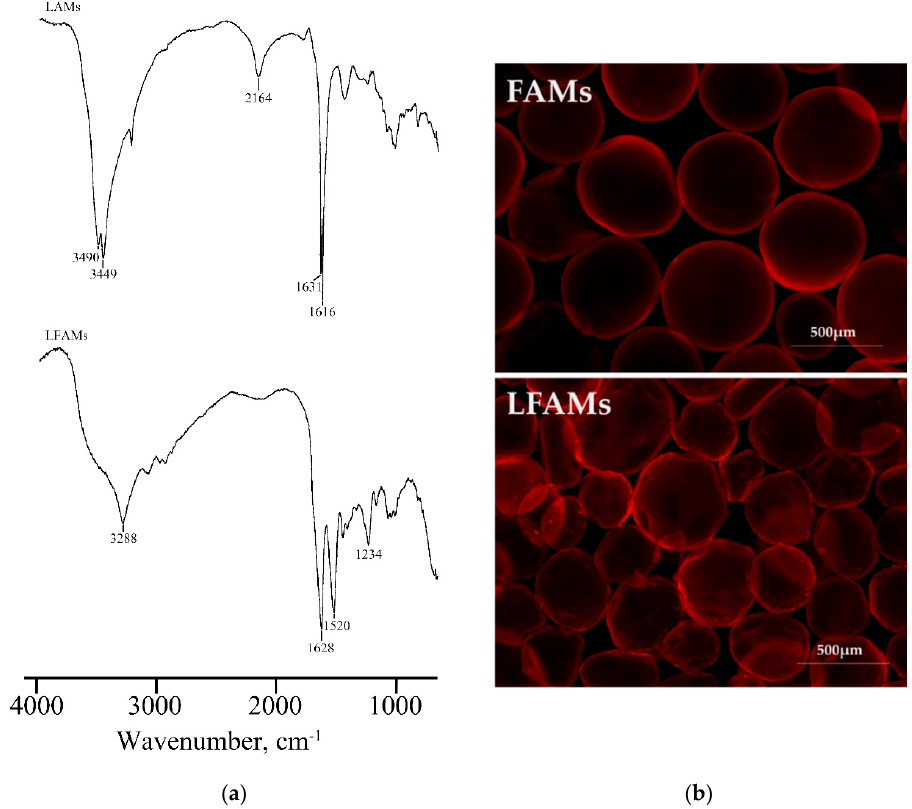
Figure 1. Fourier transform infrared (FT-IR) spectra of lyophilized alginate microcarriers (LAMs) and lyophilized fibroin-coated alginate microcarriers (LFAMs) in the spectral region 4000–1000 cm − 1 ( a ). Representative micrographs of fibroin-coated microcarriers (FAMs) and LFAMs after exposition at green light. Magnification 4X ( b ).